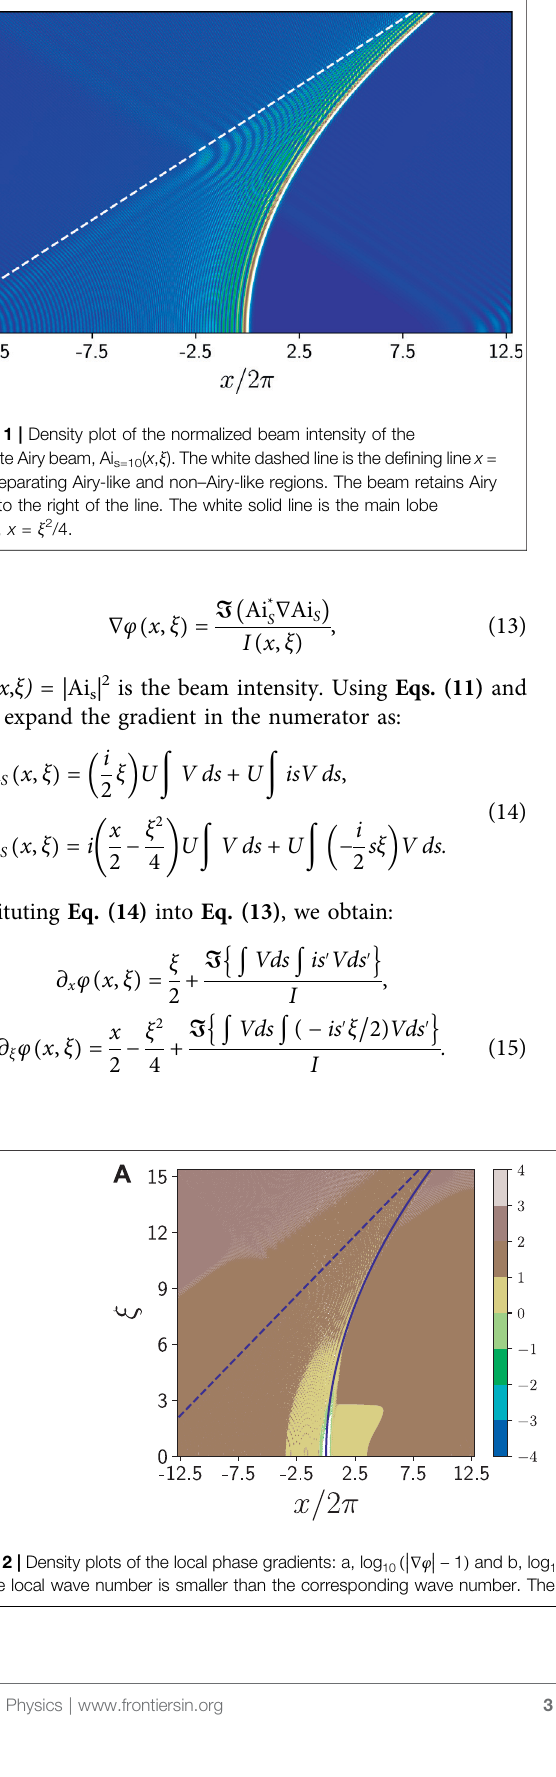
Frontiers in Physics |